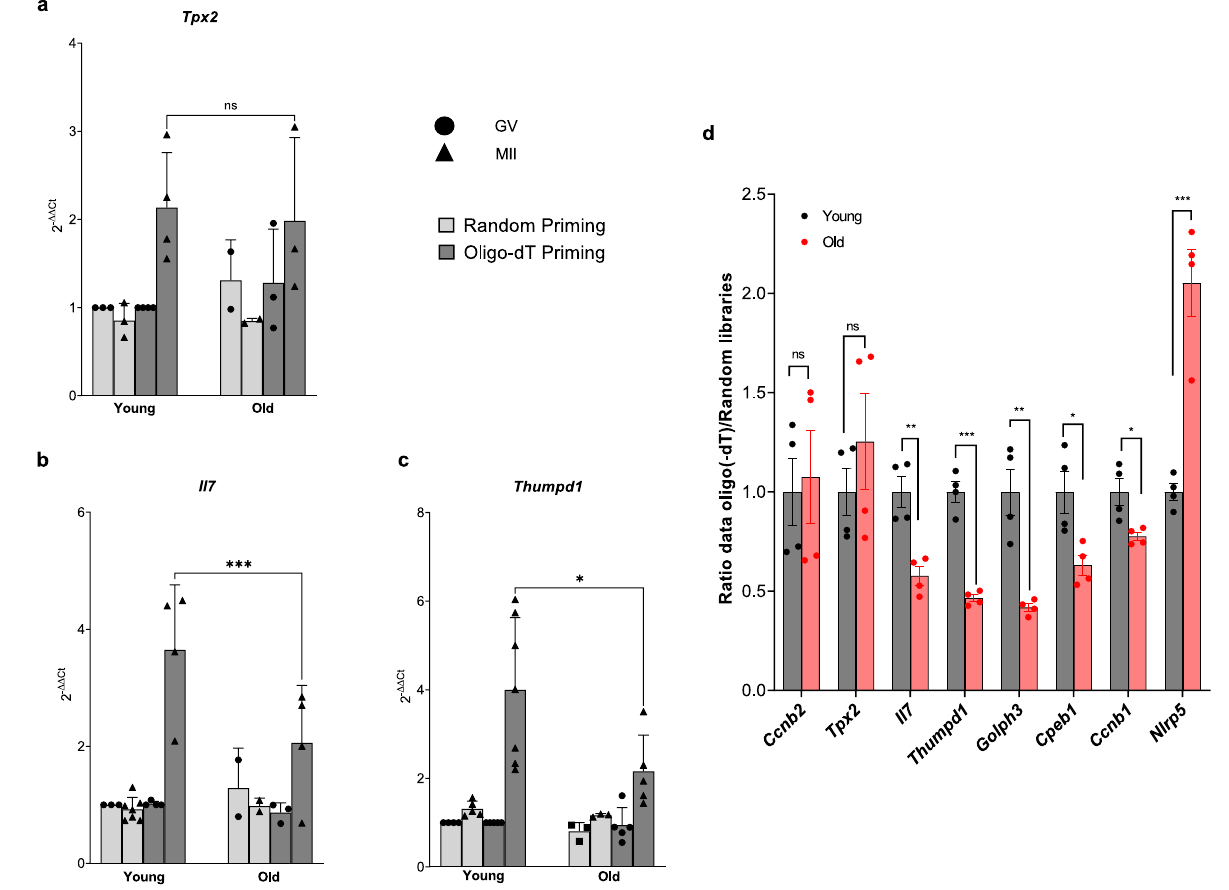
Fig. 3 | Endogenous mRNA Polyadenylations are altered with maternal aging. a – c RNA of GV or MII oocytes from young or old mice was reverse-transcribed usingrandomhexameroroligo(-dT)primers,andquantitativePCRwasperformed with gene-speci fi c primers. Data are normalized by the average expression of Dppa3 , Rpl19 , ActB ,and Eif4a1 asdetailedin “ Methods ” . a n =3(GVyoungrandom), 3(MIIyoung random), 4(GVyoungoligo(-dT)), 4(MIIyoungoligo(-dT)),2(GVold random), 2 (MII old random), 3 (GV old oligo(-dT)), 3 (MII old oligo(-dT)) biologi- cally independent samples are used. b n =3 (GV young random), 7 (MII young random), 4 (GV young oligo(-dT)), 4 (MII young oligo(-dT)), 2 (GV old random), 2 (MII old random), 3 (GV old oligo(-dT)), 4 (MII old oligo(-dT)) biologically inde- pendentsamplesareused. c n =4(GVyoungrandom),5(MIIyoungrandom),5(GV young oligo(-dT)), and 7 (MII young oligo(-dT)), 3 (GV old random), 3 (MII old random), 5 (GV old oligo(-dT)), 5 (MII old oligo(-dT)) biologically independent